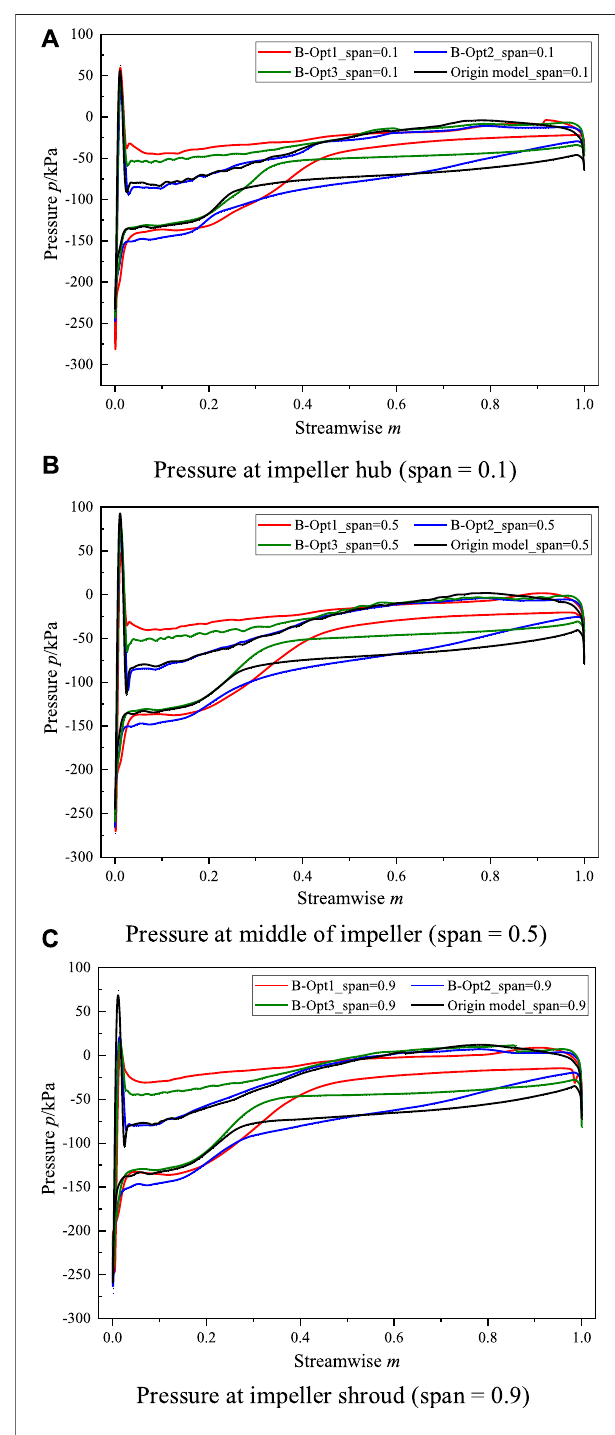
FIGURE 7 | Pressure distribution for impellers ( IGVF = 10%). (A) Pressure at impeller hub (span = 0.1). (B) Pressure at middle of impeller (span = 0.5). (C) Pressure at impeller shroud (span =